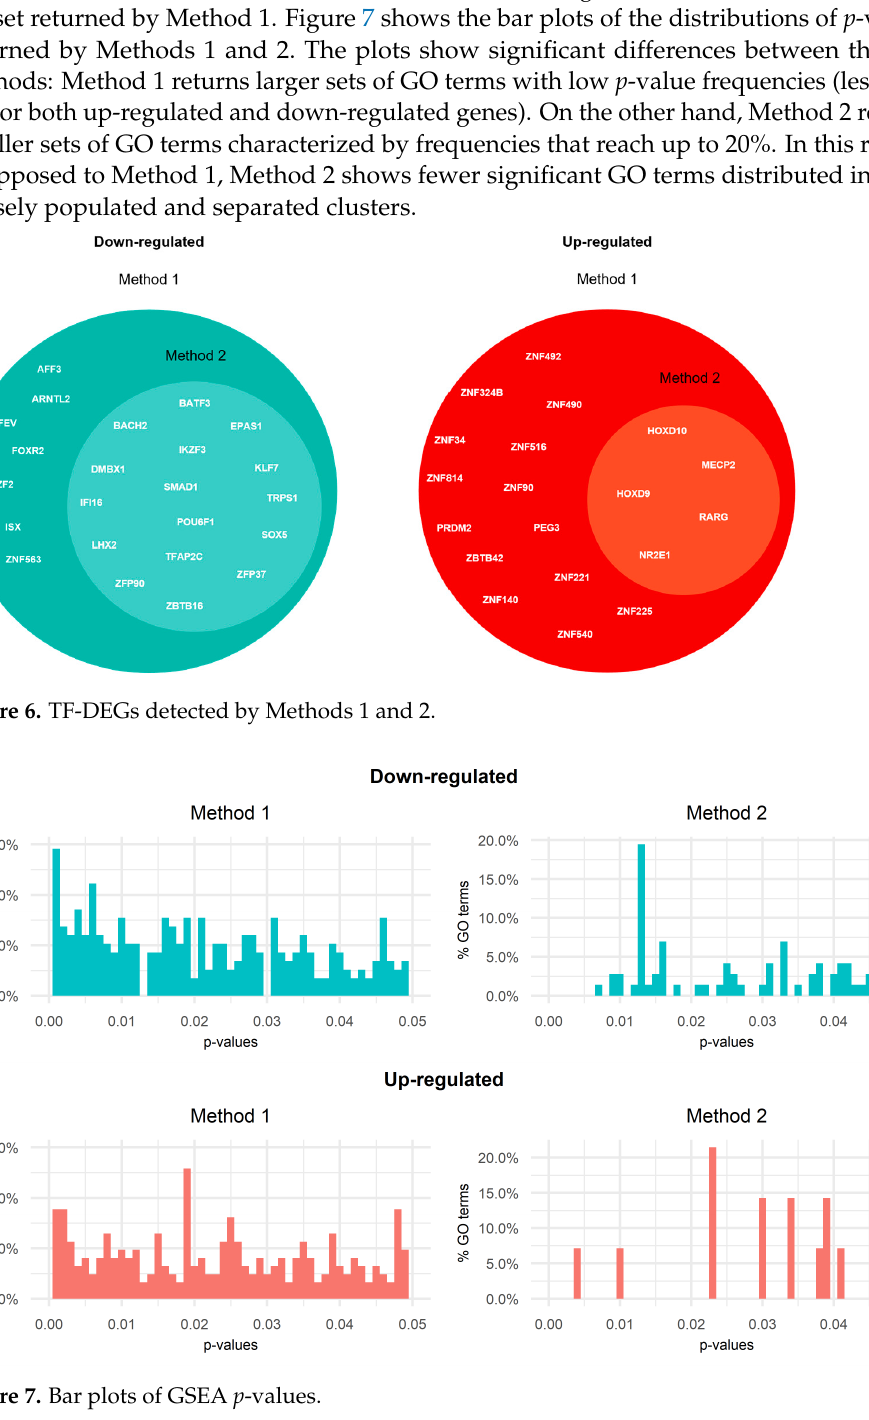
Figure 7. Bar plots of GSEA p